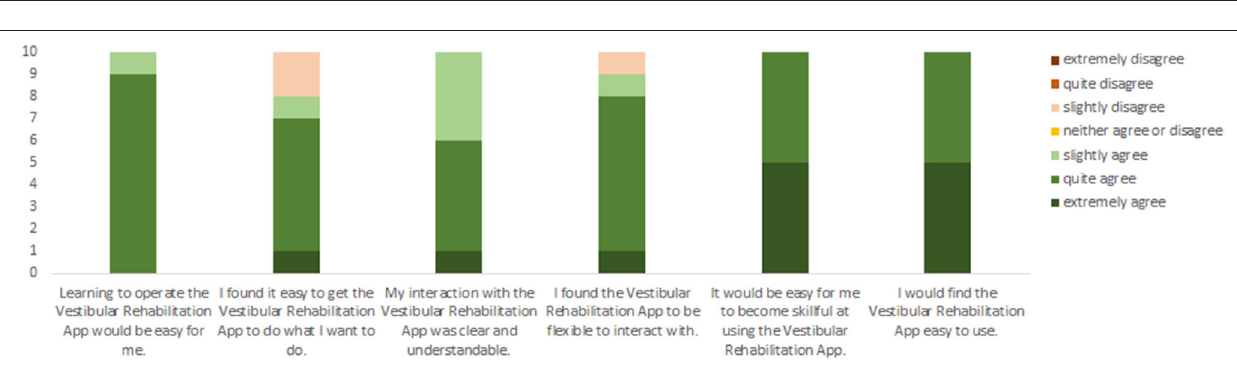
FIGURE 4 | Feedback summary on the User Interface Questionnaire. The triangles show the averages of all subjects and the bars show the standard deviation.